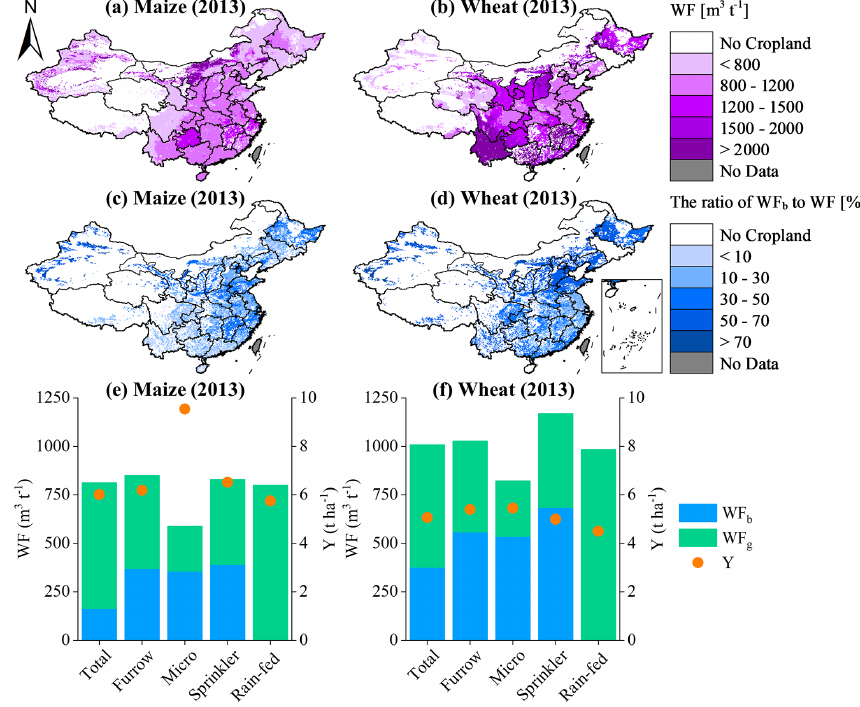
Figure 4. The WFs of maize and wheat in China in 2013.